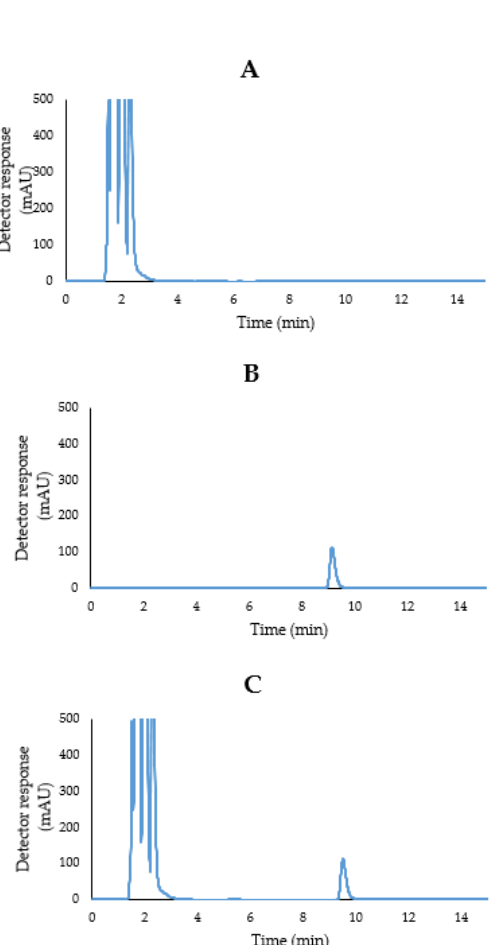
Figure 2. Chromatograms of Lipoflex special without OND ( A ), ondansetron ( B ), and Lipoflex special with OND ( C ).